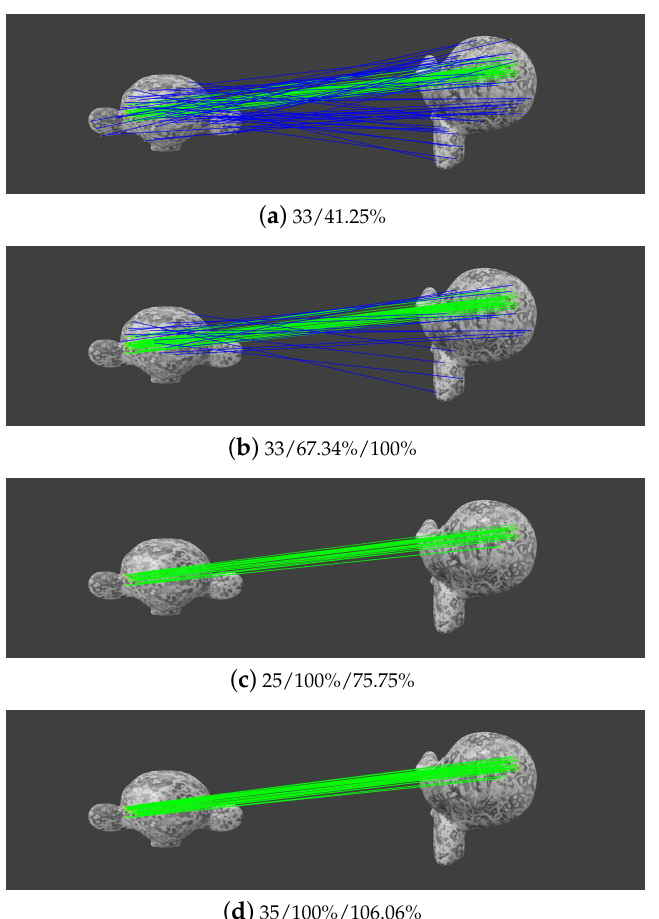
Figure 12. Image matching of one rigid pair from dataset 3. The values in sub-title ( a ) indicate the number of initial matches and its precision; the values in other sub-titles indicate the number of refined matches and its precision and